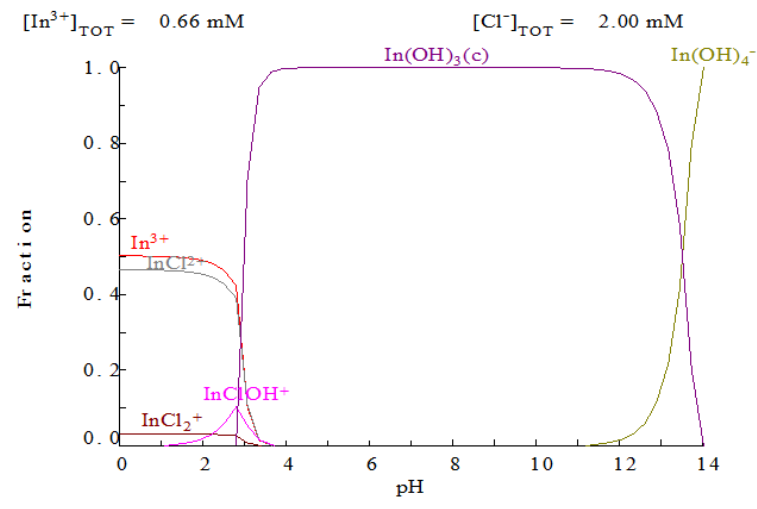
Figure 2. Indium(III) distribution depending on the pH function [31].